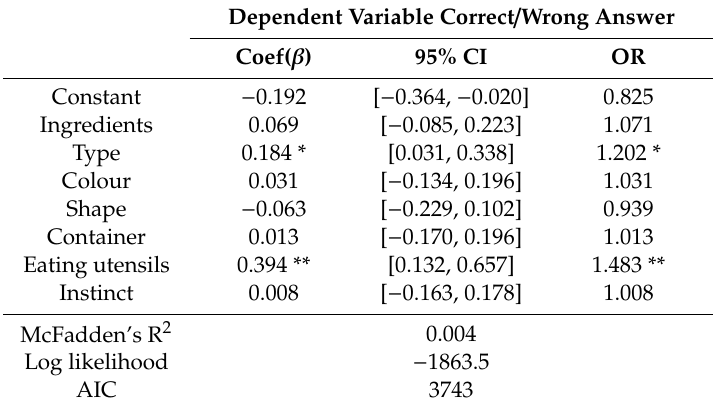
Table 6. Logistic regression model of participants’ judgements.